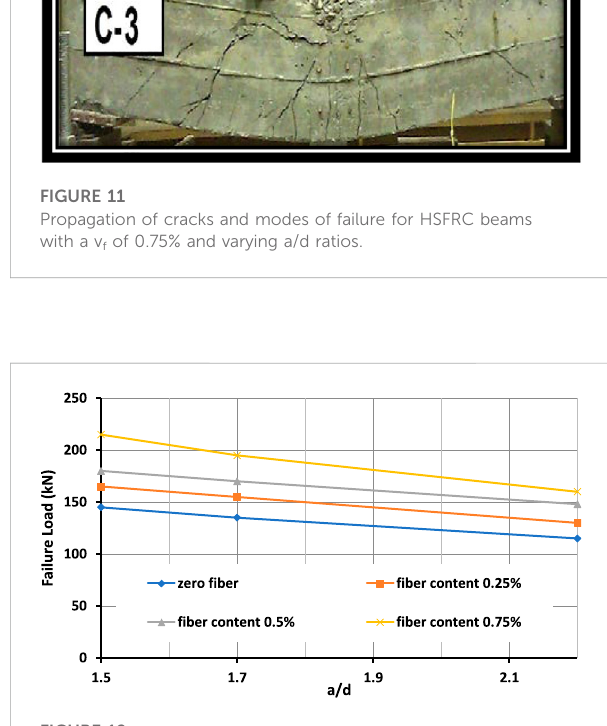
FIGURE 12 In fl uence of shear span-to-depth ratios on the tested beams.